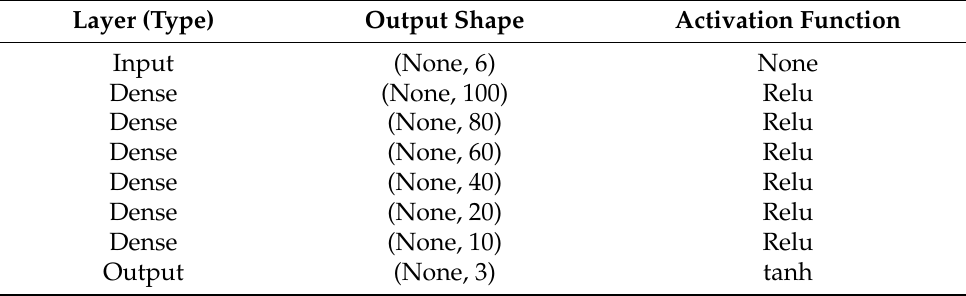
Table 3. The architecture of network for learning linear